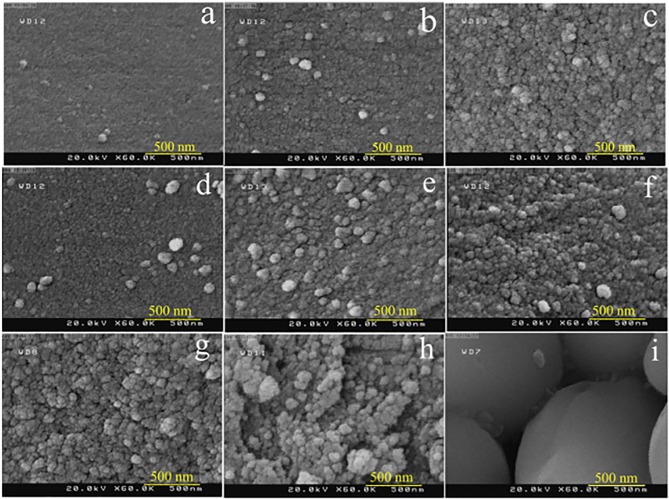
SEM images of the samples prepared at (a) 120°C, (b) 150°C and (c) 180°C for 6 h, at 120°C for (d) 12 and 18 h (e) and SEM images of the samples prepared in the absence of (f) CTAB, (g) PVP, SDS (h) and SEM image of sample no. 11 obtained from CuCl2.2H2O and CrCl3.6H2O in presence of NH3 as pH regulator via hydrothermal method (i).